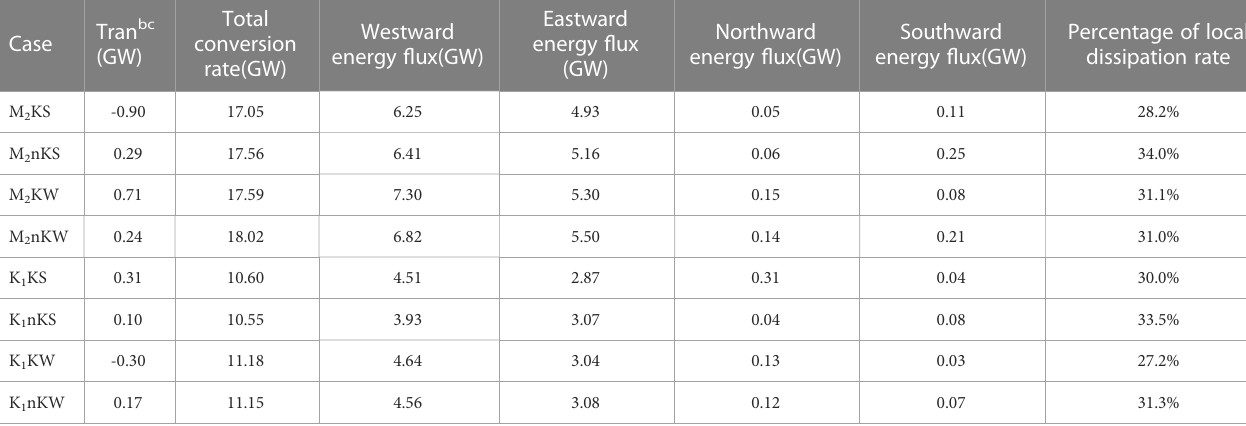
TABLE 3 The internal tide energy budget in the LS region (gray box, Figure 6A